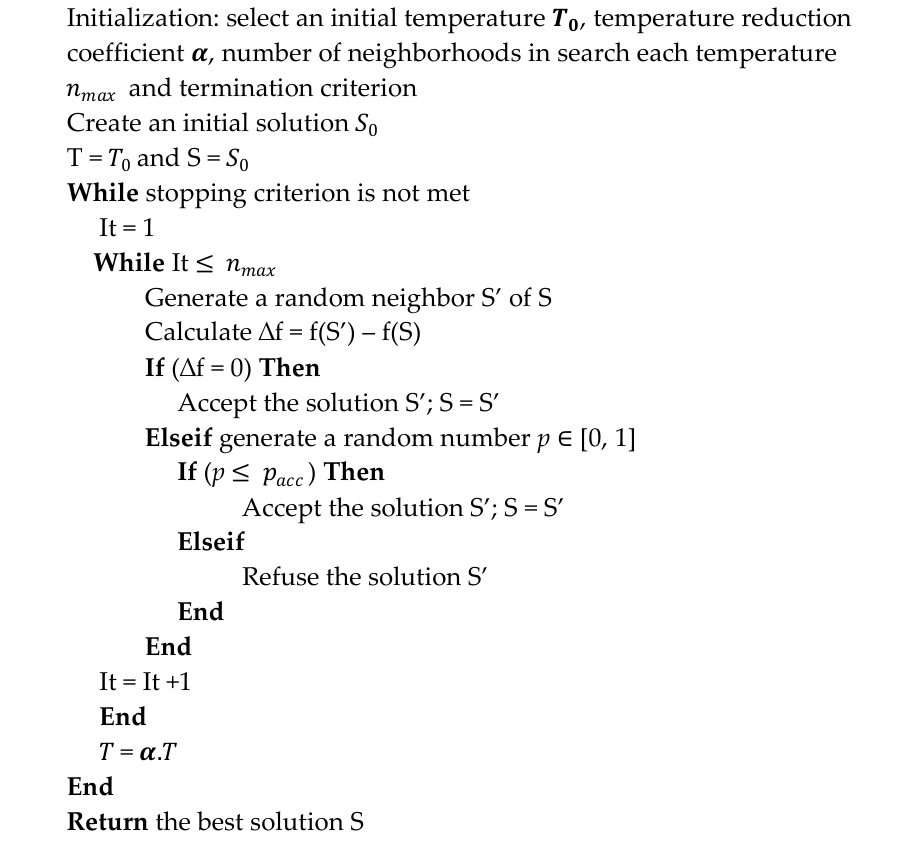
Figure 6. Pseudocode of the used simulated annealing algorithm.